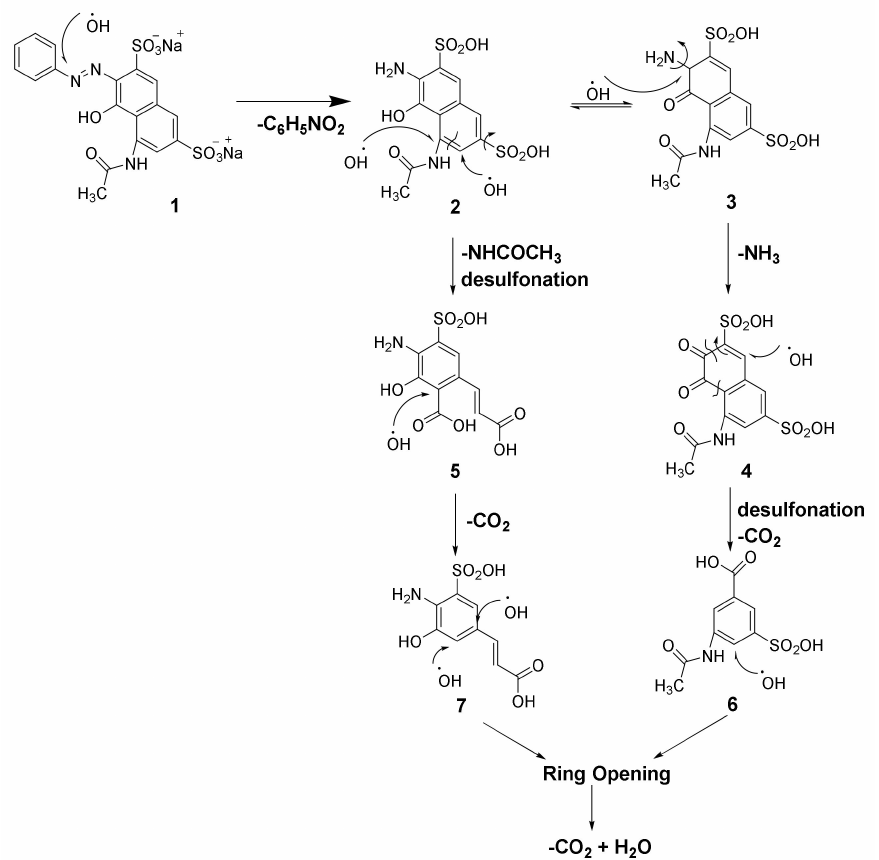
Figure 9. AR 1 degradation mechanism through oxidation by radicals •